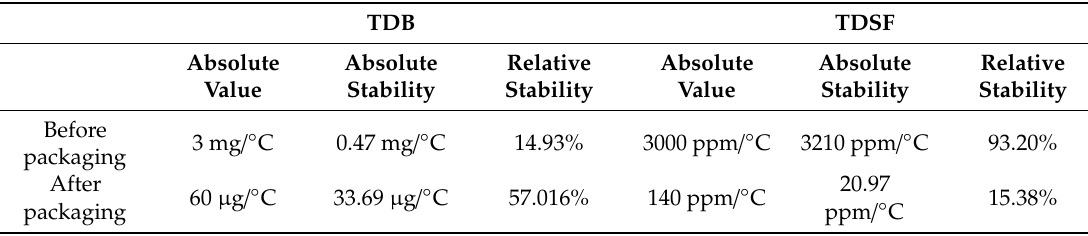
Figure 23. TDSF and TDB histograms about temperature distribution ( a ) Before packaging ( b ) After packaging. Table 5. The test results of the temperature drift of bias (TDB) and temperature drift of scale factor